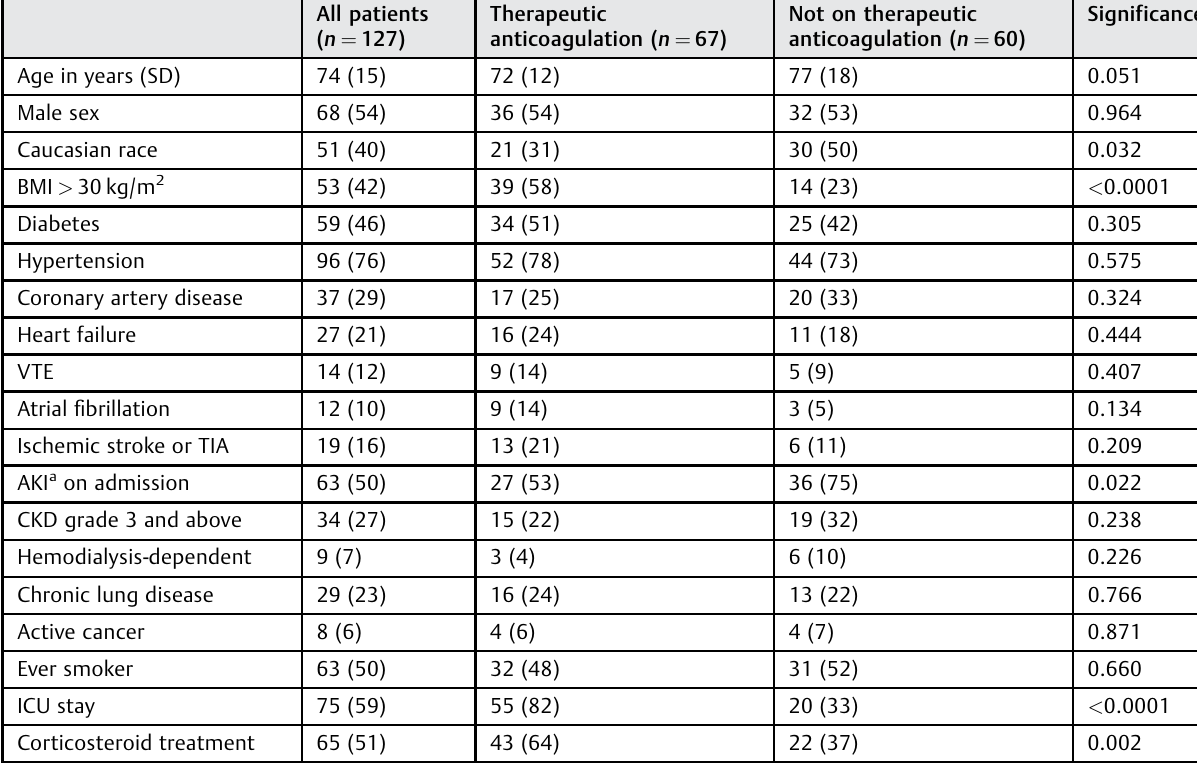
Table 1 Baseline characteristics and comorbid conditions in study population